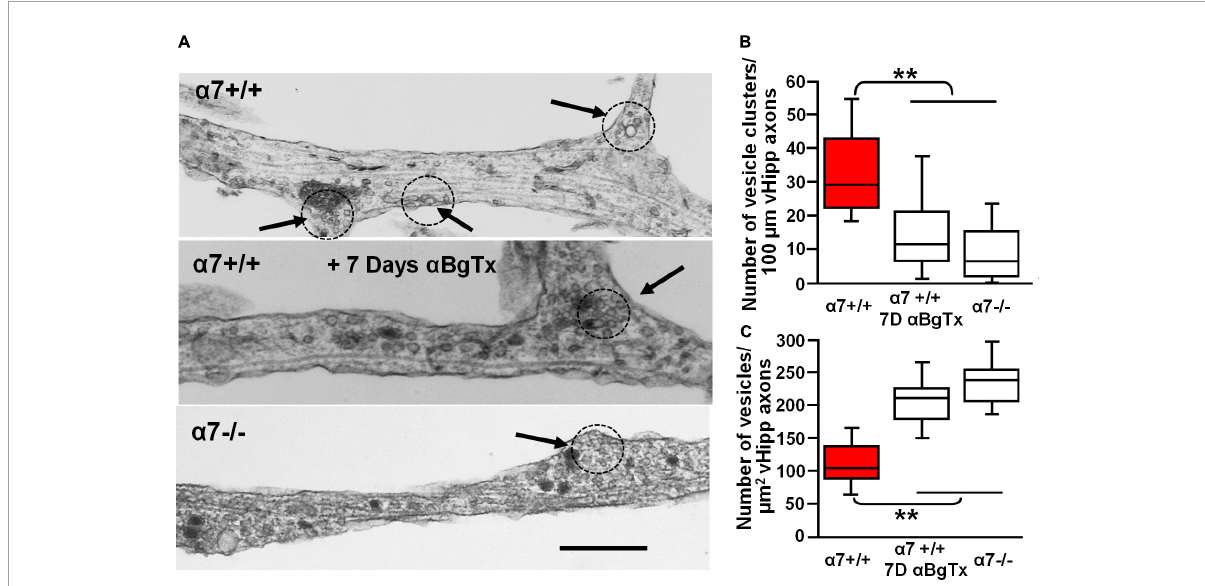
FIGURE9 Electron microscopic examination of the role of α 7* nAChRs in the organization and density of synaptic vesicles along ventral hippocampal axons. Ultrastructural analysis reveals defects in the number and organization of synaptic vesicle clusters along vHipp axons with either genetic deletion or pharmacological block of α 7* nAChRs. (A) Representative electron micrographs of axons emanating from control α 7+/+ vHipp micro-explants (Top), from α 7+/+ vHipp micro-explants, treated for 7-days in vitro with the α 7* nAChRs blocker, α BgTx (Middle), or α 7–/– mice (Bottom). The arrows and dotted circles indicate the location of vesicle clusters (defined as ≥ 15 vesicles within less than a vesicle diameter of one another; scale bar, 500 nm). (B) Box plot of pooled data on the number of vesicle clusters/100 µ m of axon from control α 7+/+ vHipp ( n = 20, 2) compared with α 7+/+ vHipp post 7-day exposure of α BgTx ( n = 20, 2) and with α 7–/– ( n = 20, 2). There was a significant decrease in the number of vesicle clusters along vHipp axons from either pharmacological ( α BgTx) or genetic ablation ( α 7–/–) of α 7* nAChRs compared with α 7+/+ control; ** p < 0.01. (C) Box plot of pooled data shows a significantly greater total number of vesicles per square micrometer vHipp axons from either pharmacological ( α 7+/+; post 7-day exposure of α BgTx) or genetic ablation ( α 7–/–) of α 7* nAChRs compared with α 7+/+ control; ** p <